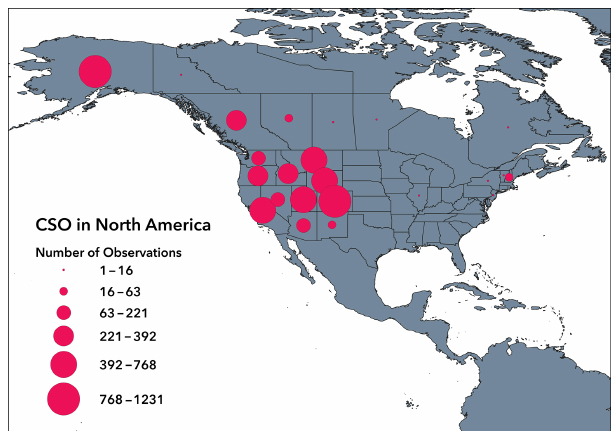
Figure 3. CSO participation in North America. Participation in the CSO project in North America aggregated by the number of obser- vations recorded in each USA state or Canadian province between 1 January 2017 and 31 December